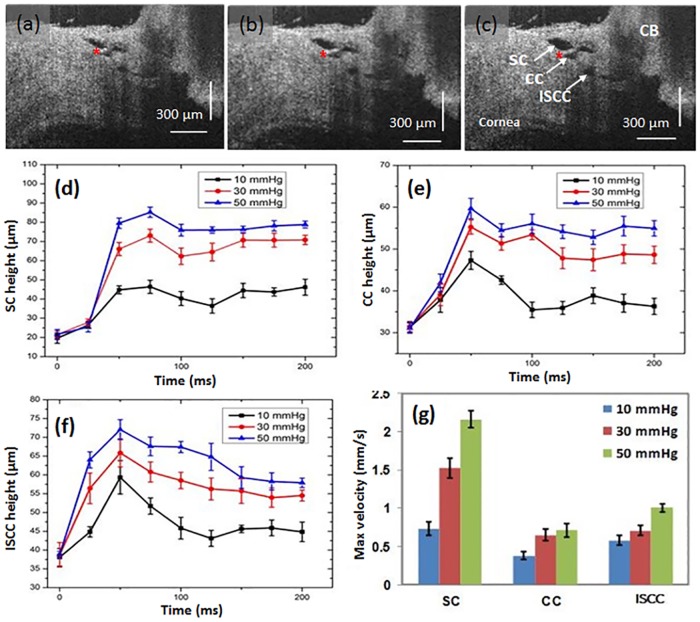
OCT images (a-c) represent a section through the limbus while maintaining cannula pressures of 10, 30, and 50 mm Hg respectively; the images represent the static configuration after having switched to the respective reservoir pressures from a baseline of 0 mm Hg pressure. The ciliary body (CB), trabecular meshwork (TM), Schlemm’s canal (SC), collector channel (CC) and intrascleral collector channels (ISCC) undergo progressive changes in shape in response to pressure increases. Red asterisks indicate the base of a hinged collagen flap. Height changes with time of the lumen of SC, CC and ISCC are depicted in (d) (e) and (f); time was determined from the initiation of height change following switching from a baseline reservoir height of 0 to a height of 10, 30 or 50 mm Hg respectively. The bar chart (g) depicts maximum velocities of SC, CC and ISCC lumen height change following pressure changes from the 0 baseline to the10, 30, or 50 mm Hg reservoir height.